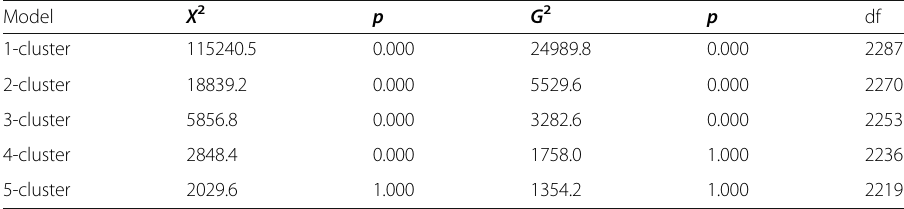
Table 3 Goodness of fit statistics of the LCA models Model X 2 p G 2 p df 1-cluster 115240.5 0.000 24989.8 0.000 2287 2-cluster 18839.2 0.000 5529.6 0.000 2270 3-cluster 5856.8 0.000 3282.6 0.000 2253 4-cluster 2848.4 0.000 1758.0 1.000 2236 5-cluster 2029.6 1.000 1354.2 1.000